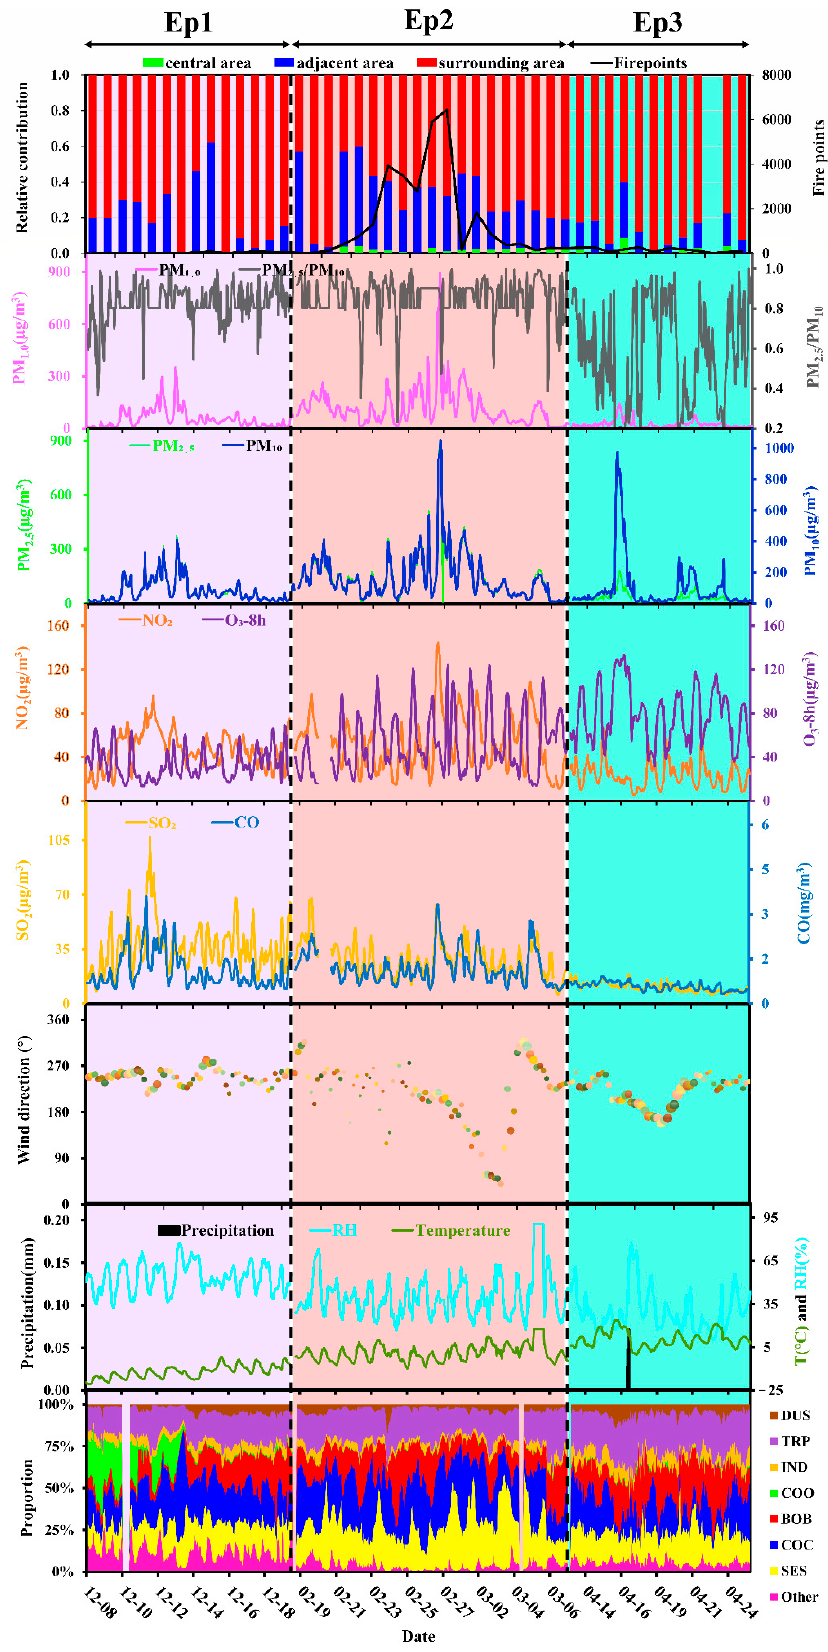
Figure 8. Diurnal variation of pollutants concentration and meteorological elements during Ep1, Ep2 and Ep3.